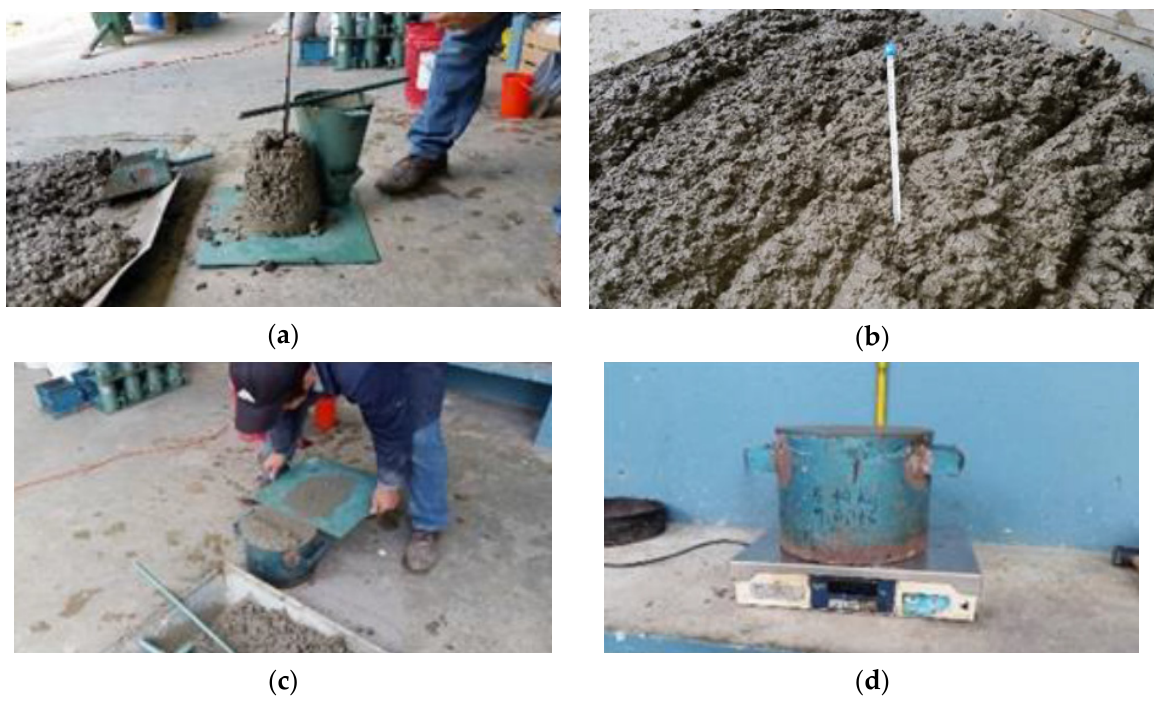
Figure 1. Tests of ( a ) Slump, ( b ) Temperature, ( c , d ) Unit weight.